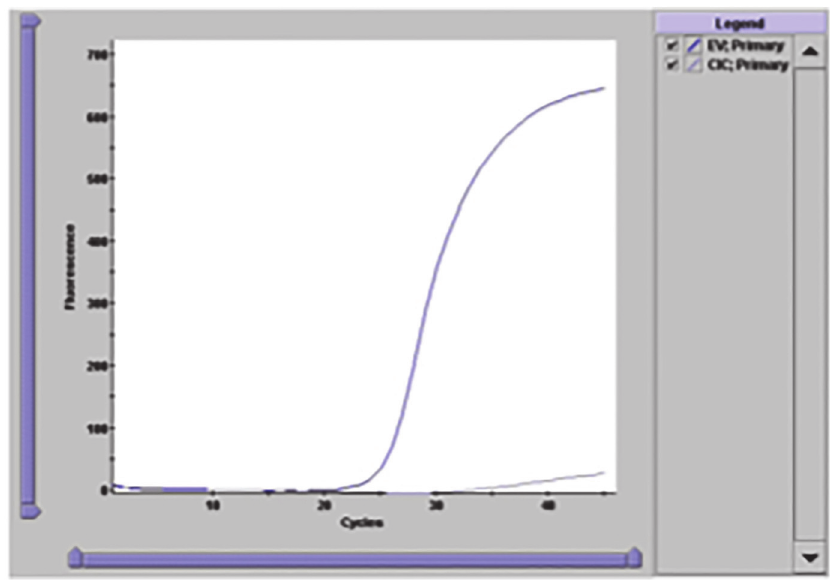
Fig 2. Detection of enterovirus in sample 13 using the GeneXpert enterovirus assay. As independent confirmation of the sequencing results for sample 13, we analyzed extracted nucleic acid on the GeneXpert platform. Sample 13, which had a RVP signal for HRV of 21.3 nA, gave a positive signal (blue line) with a C T of 24.2 and an excellent amplification curve consistent with positive results obtained from CSF samples, whereas the internal control (CIC) amplified less efficiently, as expected, because of competition (gray line).